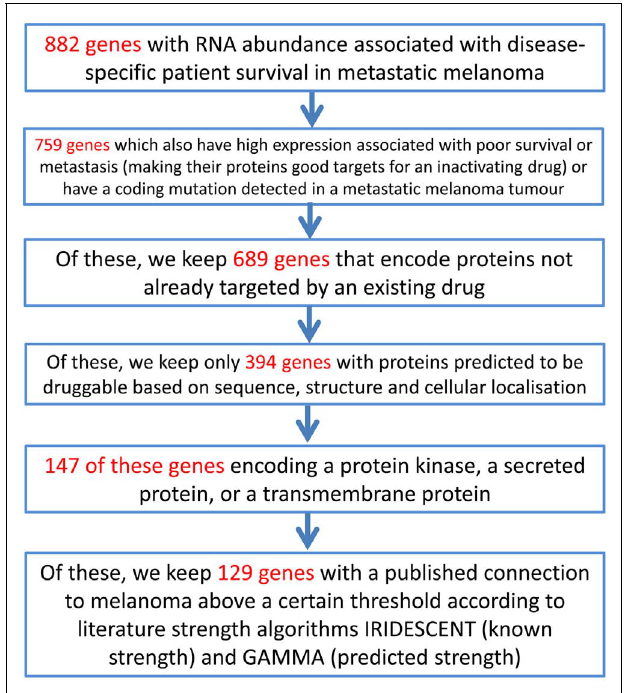
FIGURE 3 |An example of a process through which the melanoma data matrix (Data Sheet 2 in Supplementary Material) can be used to generate a short list of putative drug targets .The initial gene list consists of those genes in the melanoma data matrix (Data Sheet 2 in Supplementary Material) that have an entry in any of the columns describing the data of the studies of Jönsson et al. (51), John et al. (46), Mandruzzato et al. (47), Journe et al. (48), or Bogunovic et al. (50). (Please note that this example is for use with the data matrix in Data Sheet 2 in Supplementary Material, rather than for the MelanomaDB web